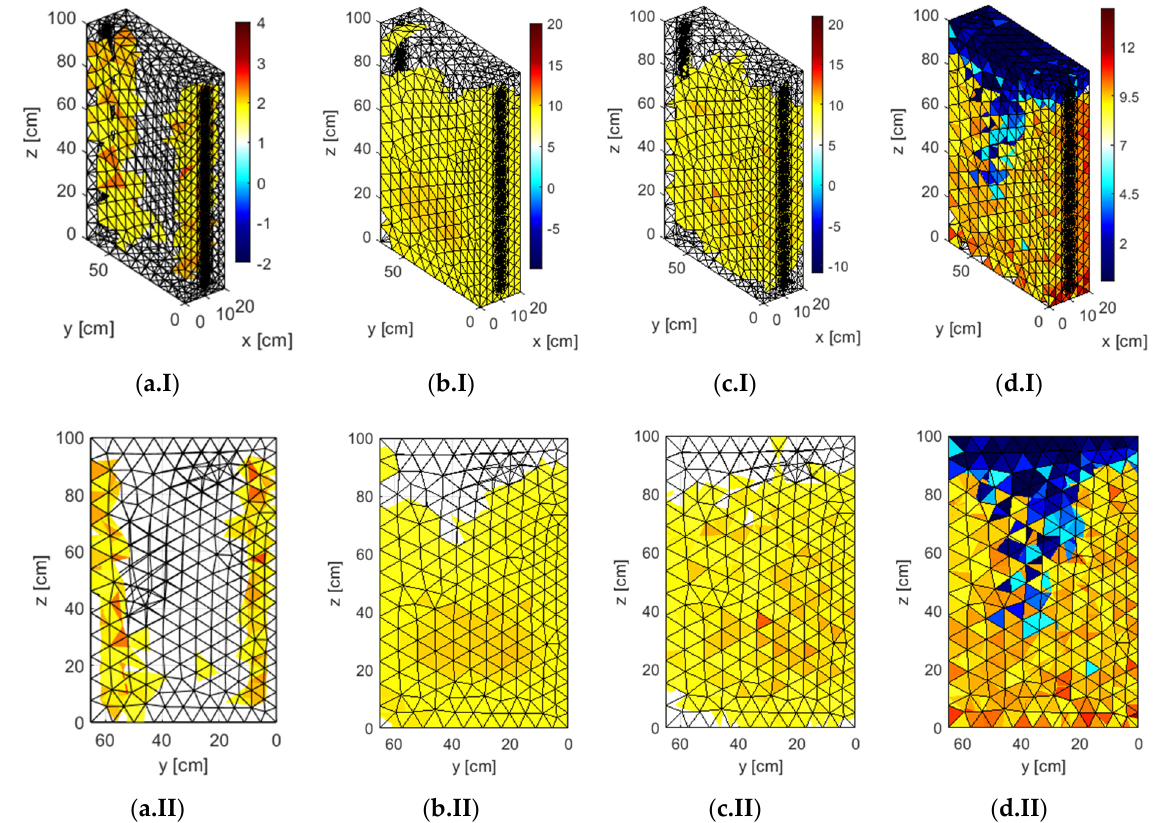
Figure 12. Reconstructions obtained from real measurements: ( a.I ) and ( a.II ) refers to GN, ( b.I ) and ( b.II ) refers to LR-SVM, ( c.I ) and ( c.II ) refers to LR-LS, ( d.I ) and ( d.II ) refers to ANN.